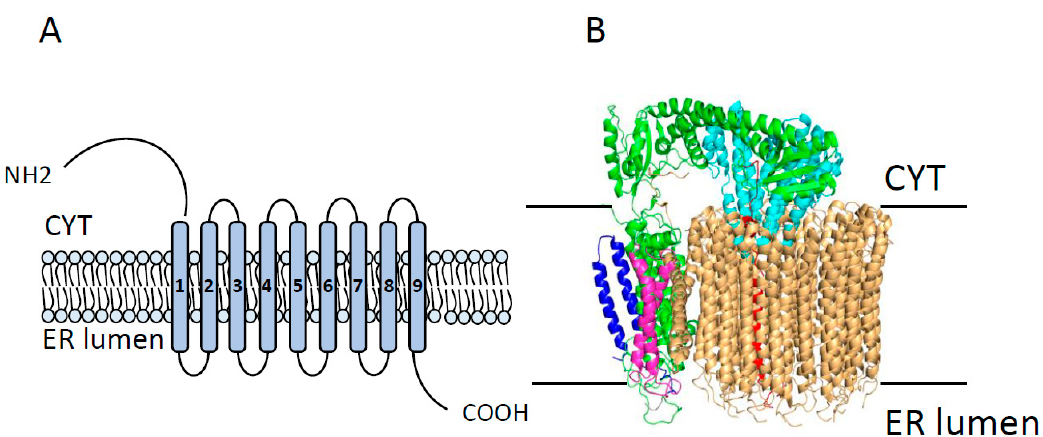
Figure 4. Overall structure of the V0 domain of V-ATPase. ( A ) Topology of V0 domain showing its 9 transmembrane segments with large cytoplasmic N-terminal and C-terminal domains. ( B ) The overall architecture of the V0 domain of V-ATPase (Protein Data Bank [PDB] code 6C6L), showing all known components of the V0 domain, including subunits a (in red), d (in cyan), e (in blue), f (in pink), and the c-ring (in wheat). CYT = cytoplasm; ER lumen = endoplasmic reticulum lumen. Modified from Roh et al. 2018.